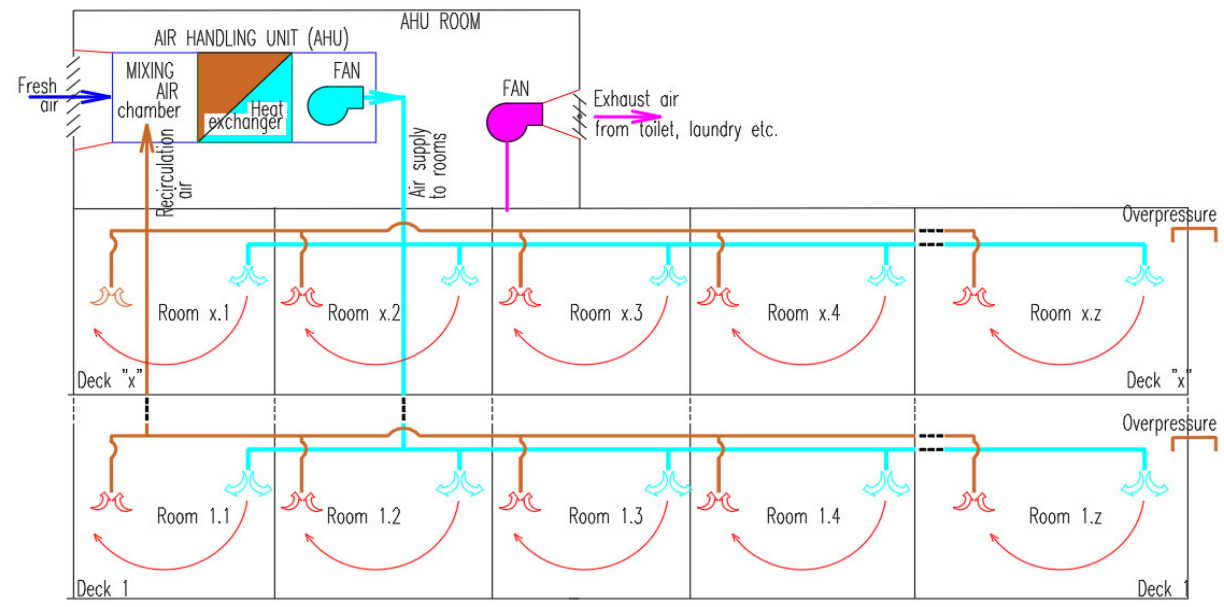
Figure 4. Typical arrangement. Common ventilation and air conditioning system for large ships, with recirculation and air mixing.